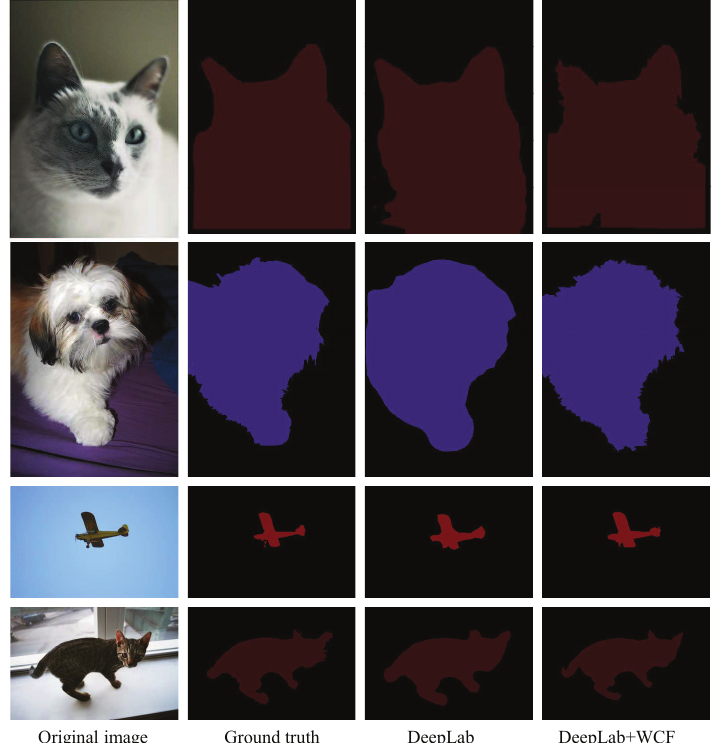
Figure 6. Enhancement of segmentation results of DeepLab. From the first row to the fourth row are cat, dog, aircraft and cat, respectively. From the first column to the fourth column are the original images, the ground truth of images, the preliminary segmentation results by DeepLab and enhancement results by the proposed methods